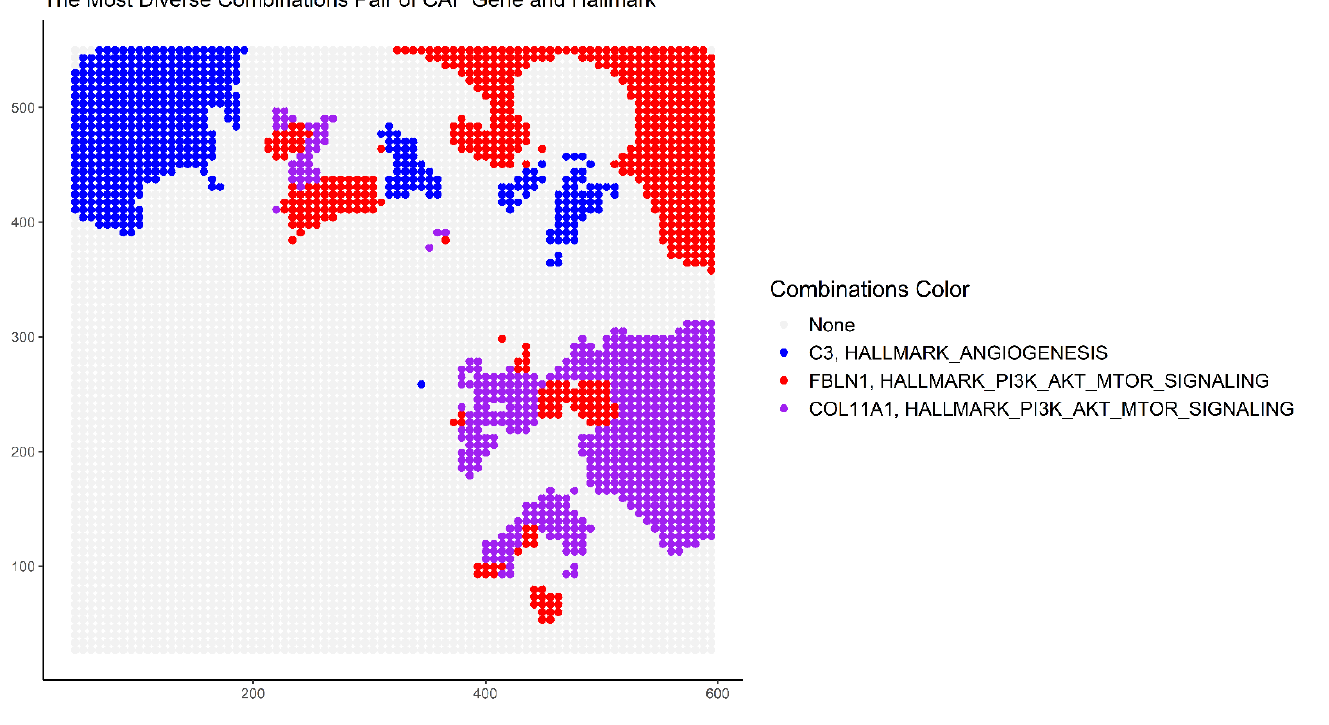
Figure 7. The co-occurrence based on Leibovici’s spatial entropy index. Taking combinations of the different CAF phenotypic contexts and cancer hallmark gene sets, the spatial heterogeneity of their co-occurrence is described. At each point, the combination with the most dominant phenotype is depicted. The colors used to represent the (CAF marker, hallmark gene set) pairs are red (FBlN1, PI3K_AKT_MTOR), blue (C3, Angiogenesis), purple (COL11A1, PI3K_AKT_MTOR), and grey (no significant CAF phenotype).